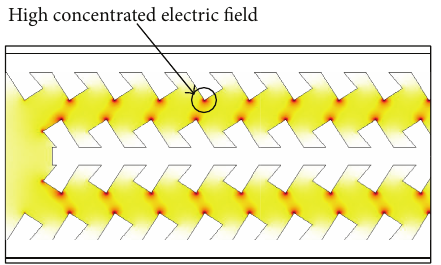
Figure 11: Electric field distribution of single finger fishbone shaped electrostatic comb drive actuator.